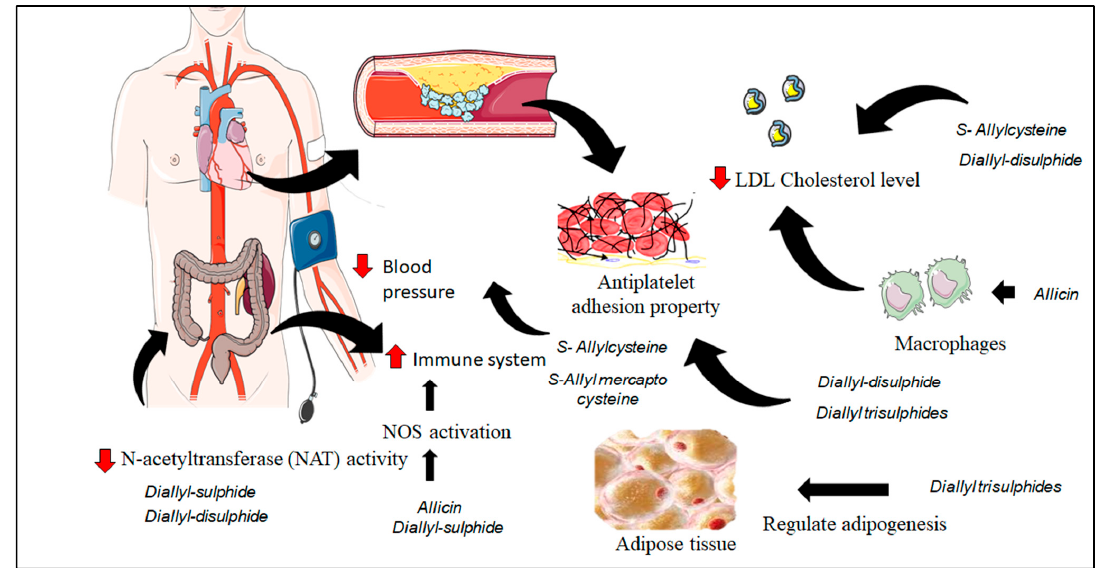
Figure 3. Biological activities of sulfur compounds from A. sativum L.